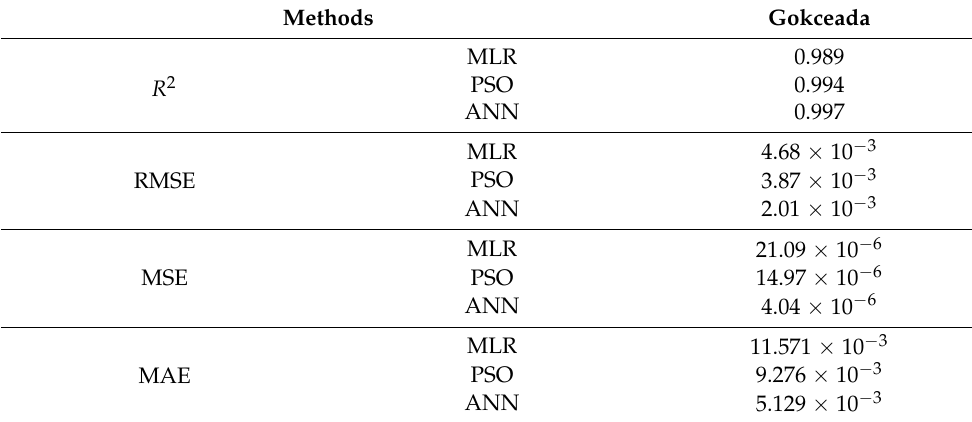
Table 3. Gokceada statistical analysis